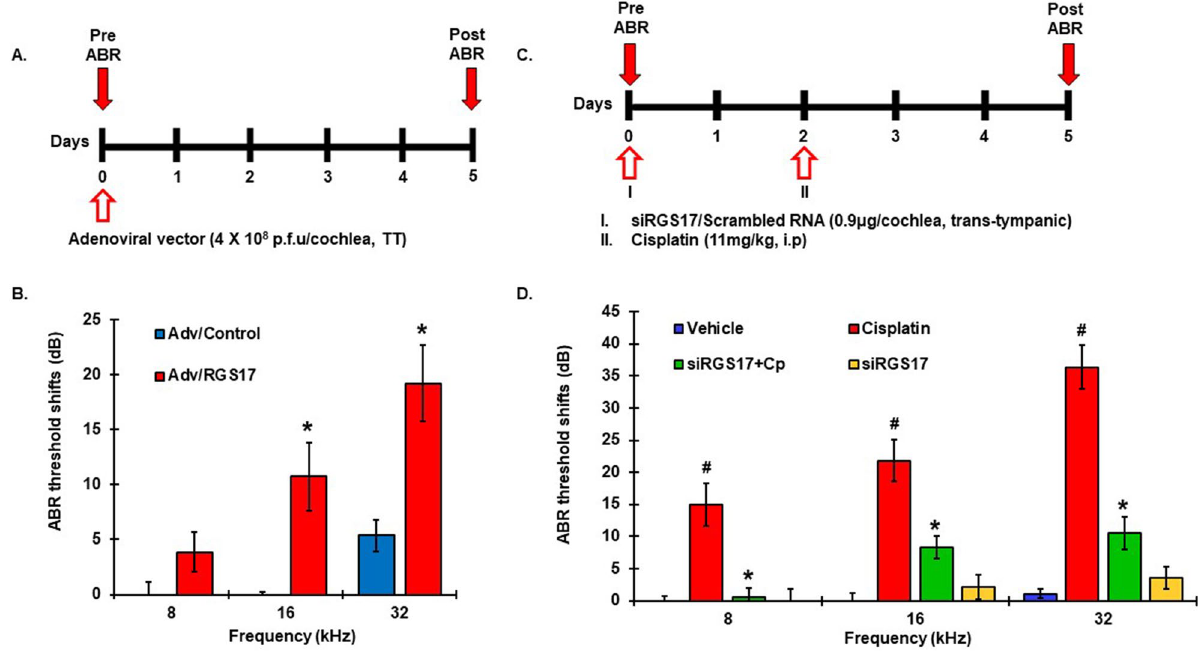
Figure 3. RGS17 overexpression compromised hearing ability whereas knocking down of RGS17 rescued hearing in rats. ( A ) Schematic diagram of the experimental protocol that illustrates the dosage and routes of administration of different treatment. Pre-treatment ABRs were measured prior to any drug administration on naïve male Wistar rats. Rats were administered either control adenoviral vector or adenoviral vector overexpressing RGS17 into ears via trans-tympanic delivery and post-treatment ABRs were assessed after 5 days. ( B ) Adenoviral vector overexpressing RGS17 in one ear showed significant increase in ABR threshold shifts than the control ear at 16 and 32 kHz. ( C ) Schematic diagram showing siRGS17 or scrambled RNA trans-tympanically administered immediately after pre-ABRs. Intraperitoneal administration of cisplatin was performed 2 days later for cisplatin-treated groups. Post-treatment ABRs were determined 3 days after cisplatin treatment. ( D ) Post ABR results showed significant elevations in threshold shifts with cisplatin at 8, 16 and 32 kHz. siRGS17 pretreatment significantly attenuated cisplatin-induced elevation in ABR threshold shifts. Data indicate mean ± SEM. # p < 0.01 versus. vehicle, *p < 0.01 versus cisplatin, N = 12, two-way ANOVA. TT trans- tympanic, i.p